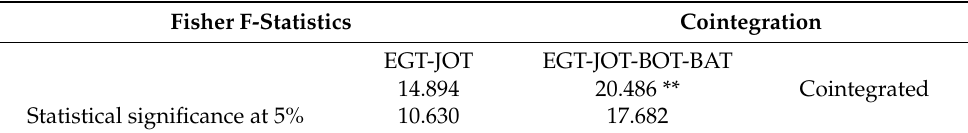
Table 4. Result of Bayer and Hanck (2013)